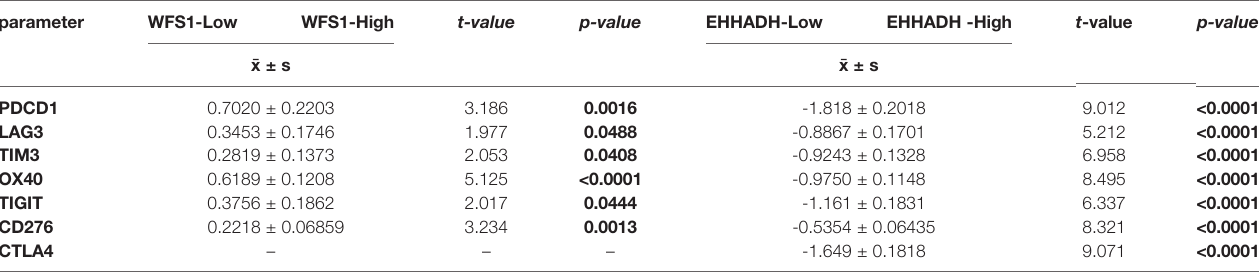
TABLE 3 | Comparison of the levels of PDCD1, LAG3, TIM3, OX40, TIGIT, CD276, and CTLA4 between the WFS1, EHHADH-high and – low subgroups.